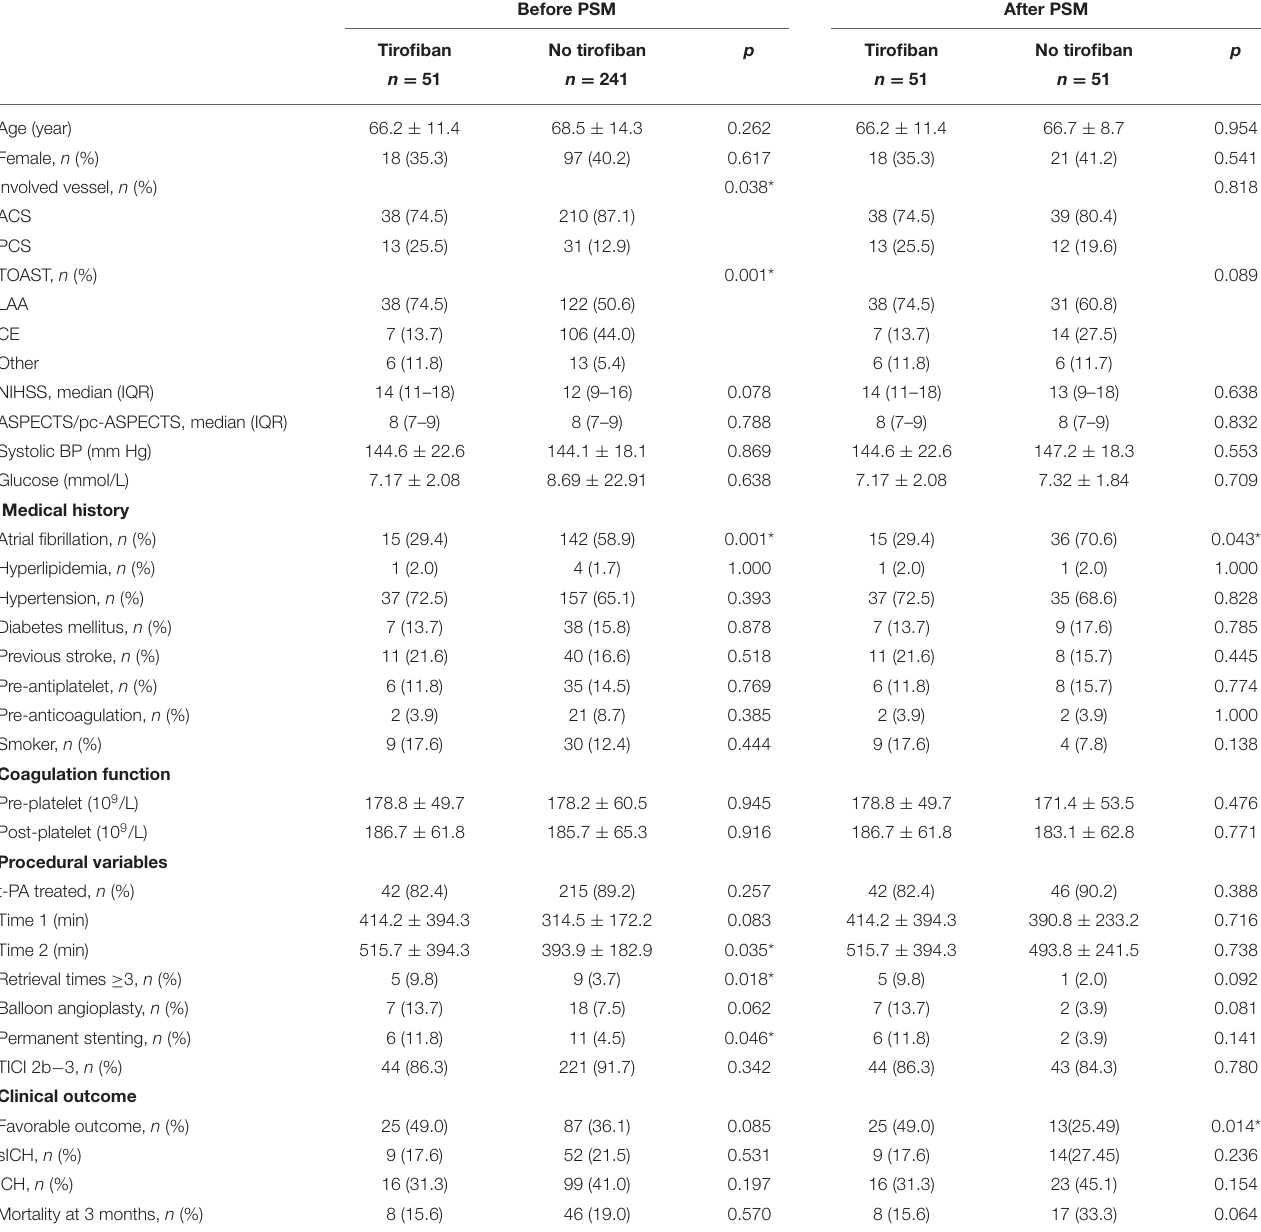
TABLE 1 | Patient characteristics and outcomes before and after